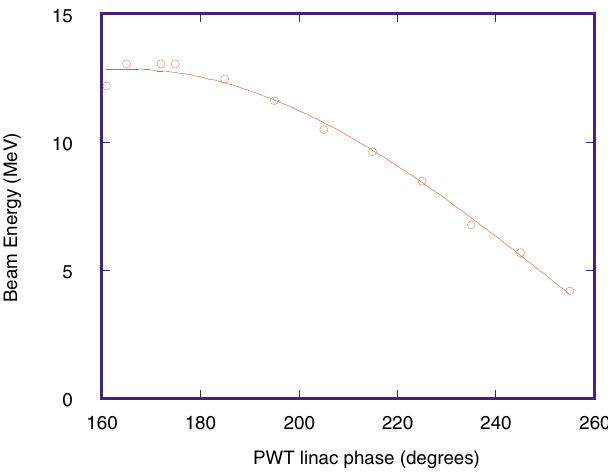
FIG. 12. (Color) Energy of central slice, measured versus the phase of the linac, as determined by maximum Faraday cup signal. Energy fit to data has assumed functional form E (cid:4) (cid:7) E (cid:3) . E sin (cid:2) (cid:18) (cid:7) (cid:18) gun PWT 0